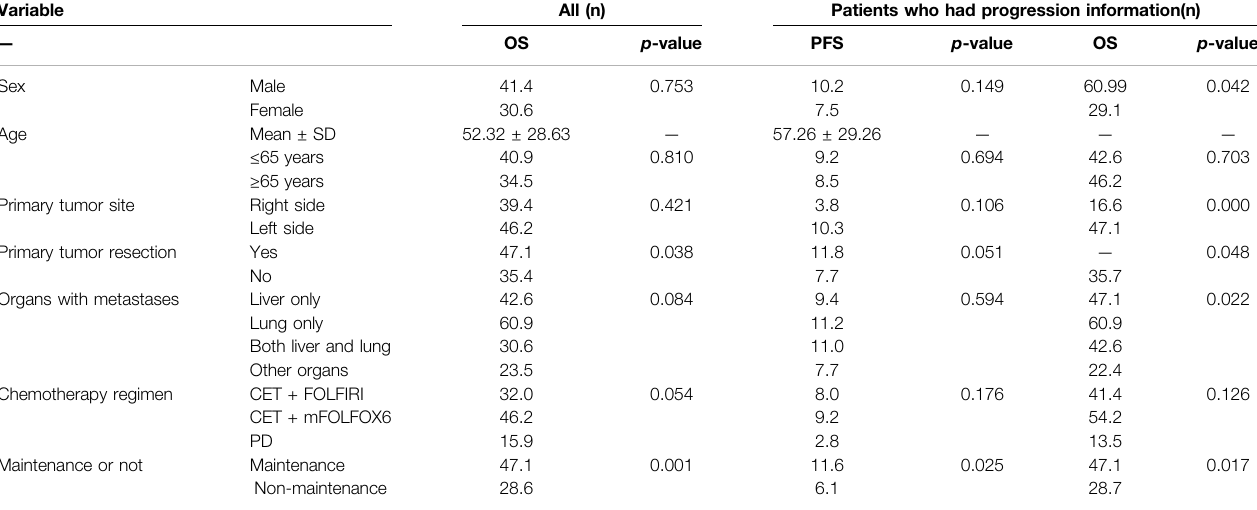
TABLE 3 | Kaplan – Meier estimates of PFS and OS. Variable All (n) Patients who had progression